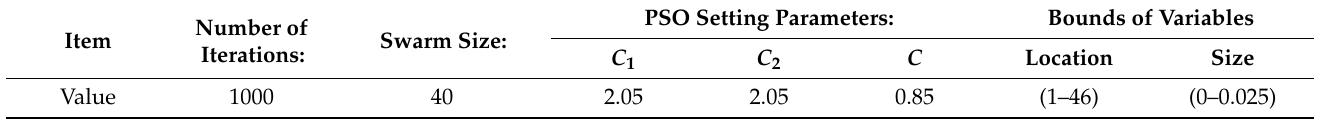
Table 1. PSO setting data for the considered optimization problem.